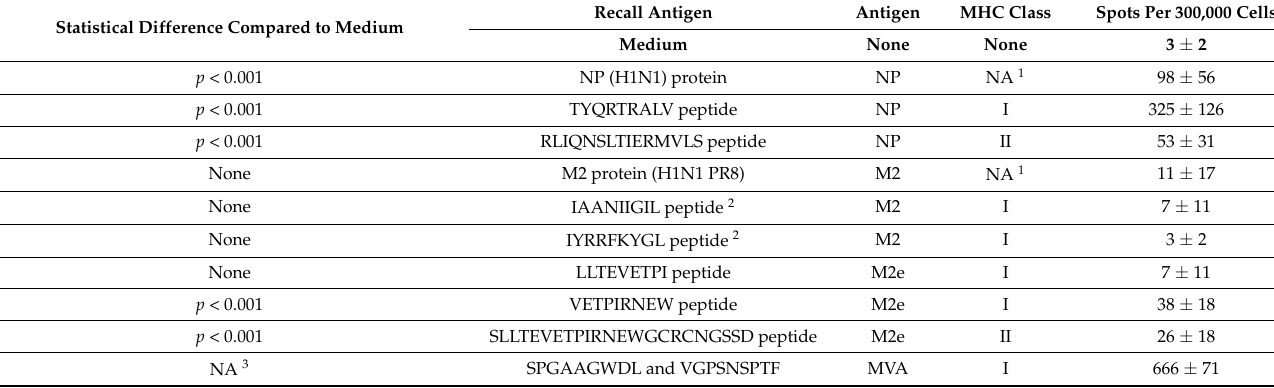
Table 3. Proteins and peptides utilized as recall antigens for ELISpot analysis of splenocytes obtained after delivery of MVA vaccines that encoded NP, M2 or M2e. p values were calculated by t -test, 2-tailed, equal variance. Influenza recall antigens were derived from proteins of H1N1 PR8 INFV